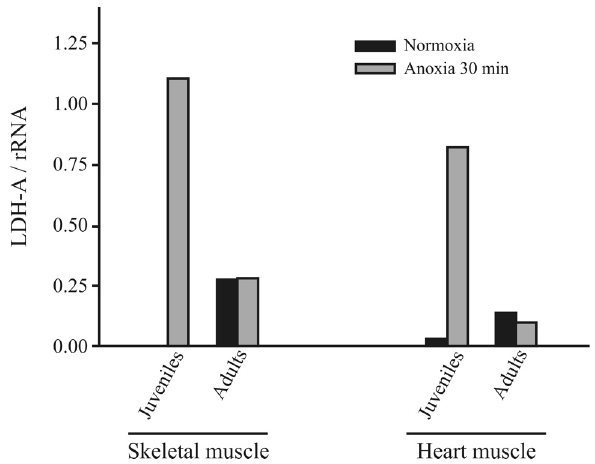
Figure 2 - LDH-A expression in white muscle and heart of juvenile and adult Astronotus crassipinis under normoxia and after 30 min of anoxia exposure.